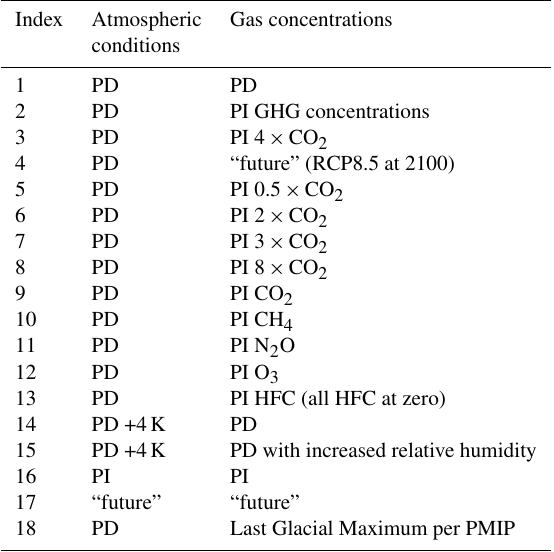
Table A1. List of atmospheric conditions and gas concentrations defining the 18 experiment variants of